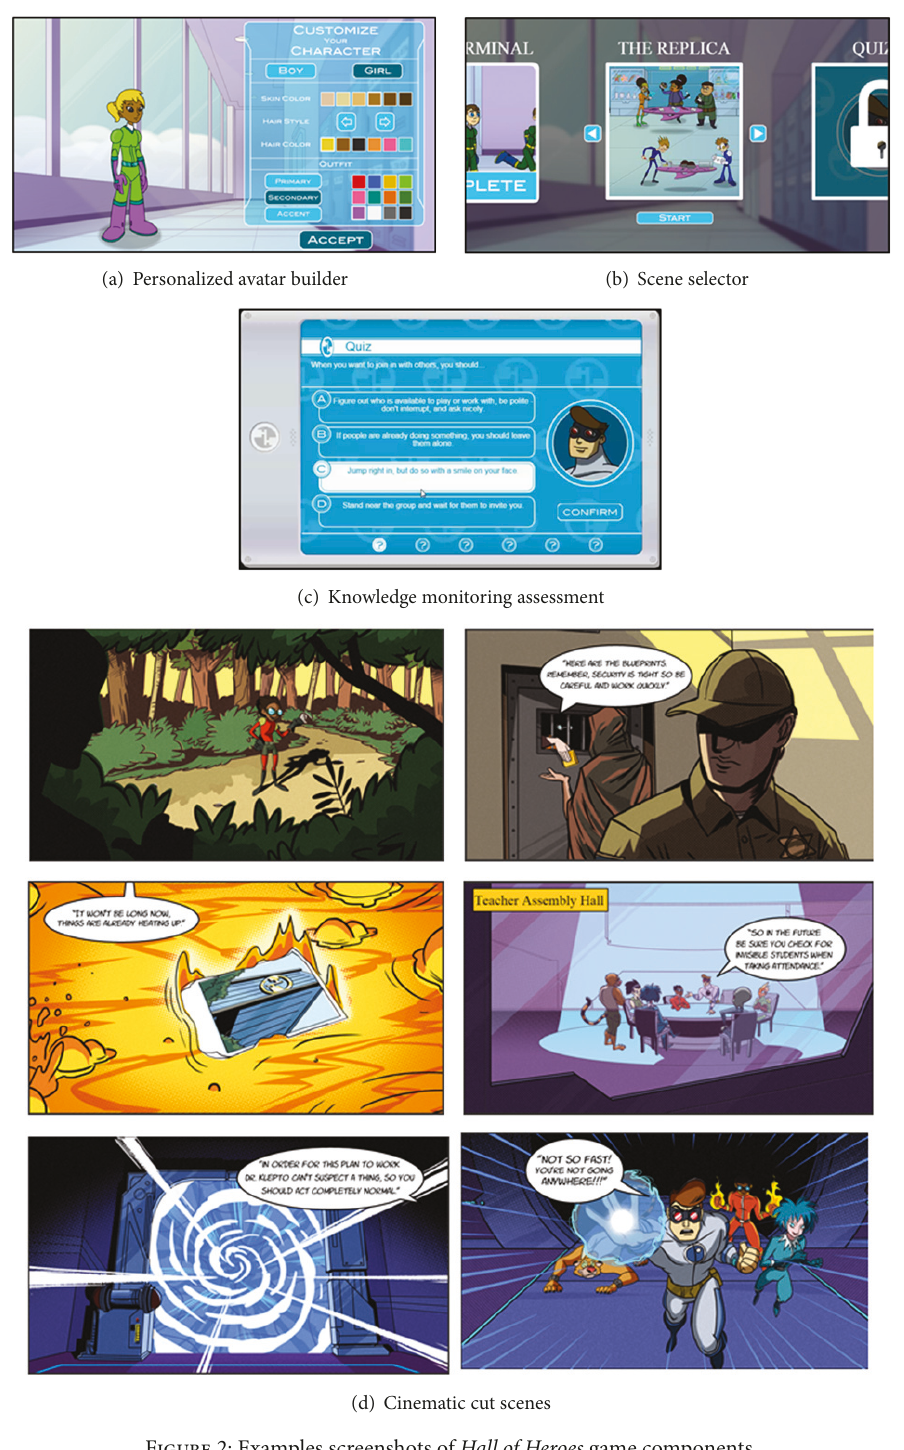
Figure 2: Examples screenshots of Hall of Heroes game